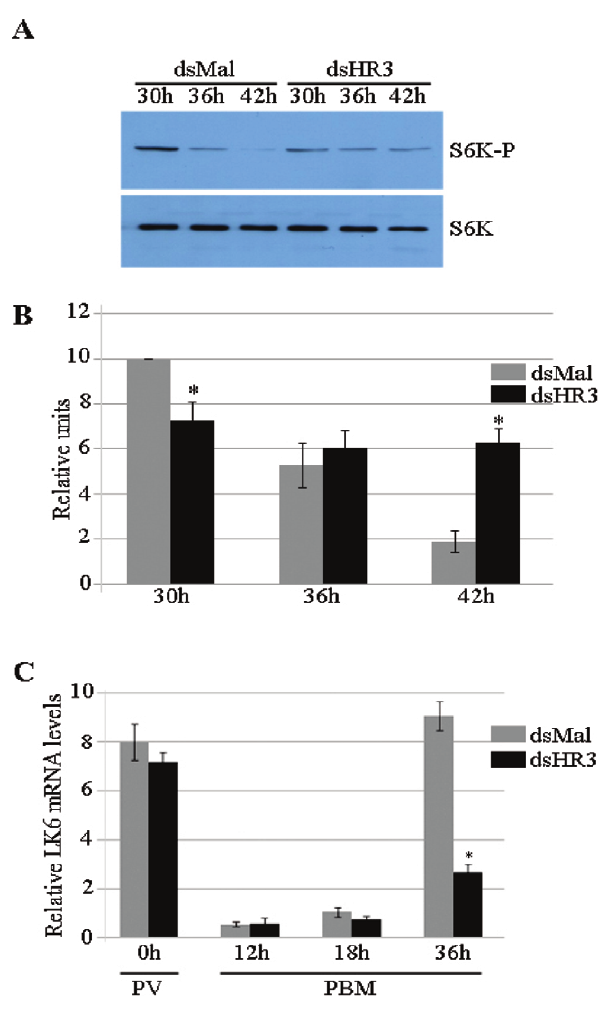
Figure 5. A delay in a timely shutdown of the TOR signaling in fat bodies of HR3-depleted Aedes female mosquitoes. (A) Western blot analysis of phospho-S6-Kinase (S6K-P) and S6-Kinase (S6K) proteins during the termination of vitellogenesis in the fat body of Aedes female mosquitoes. One fat body equivalent per lane was loaded in a SDS/PAGE gel. The experiment was done in triplicate. (B) Densitometry measurements of three independent experiments from A showing higher levels of S6K-P in dsHR3 mosquitoes. Relative units normalized to its corresponding S6K levels. *Indicates statistical significance , 0.05. (C) mRNA levels of LK6-Kinase (LK6) during the first vitellogenic cycle in FBs of female mosquitoes treated with dsMal or dsHR3 RNAi. qPCR was done as previously described. *Indicates statistical significance , 0.05.